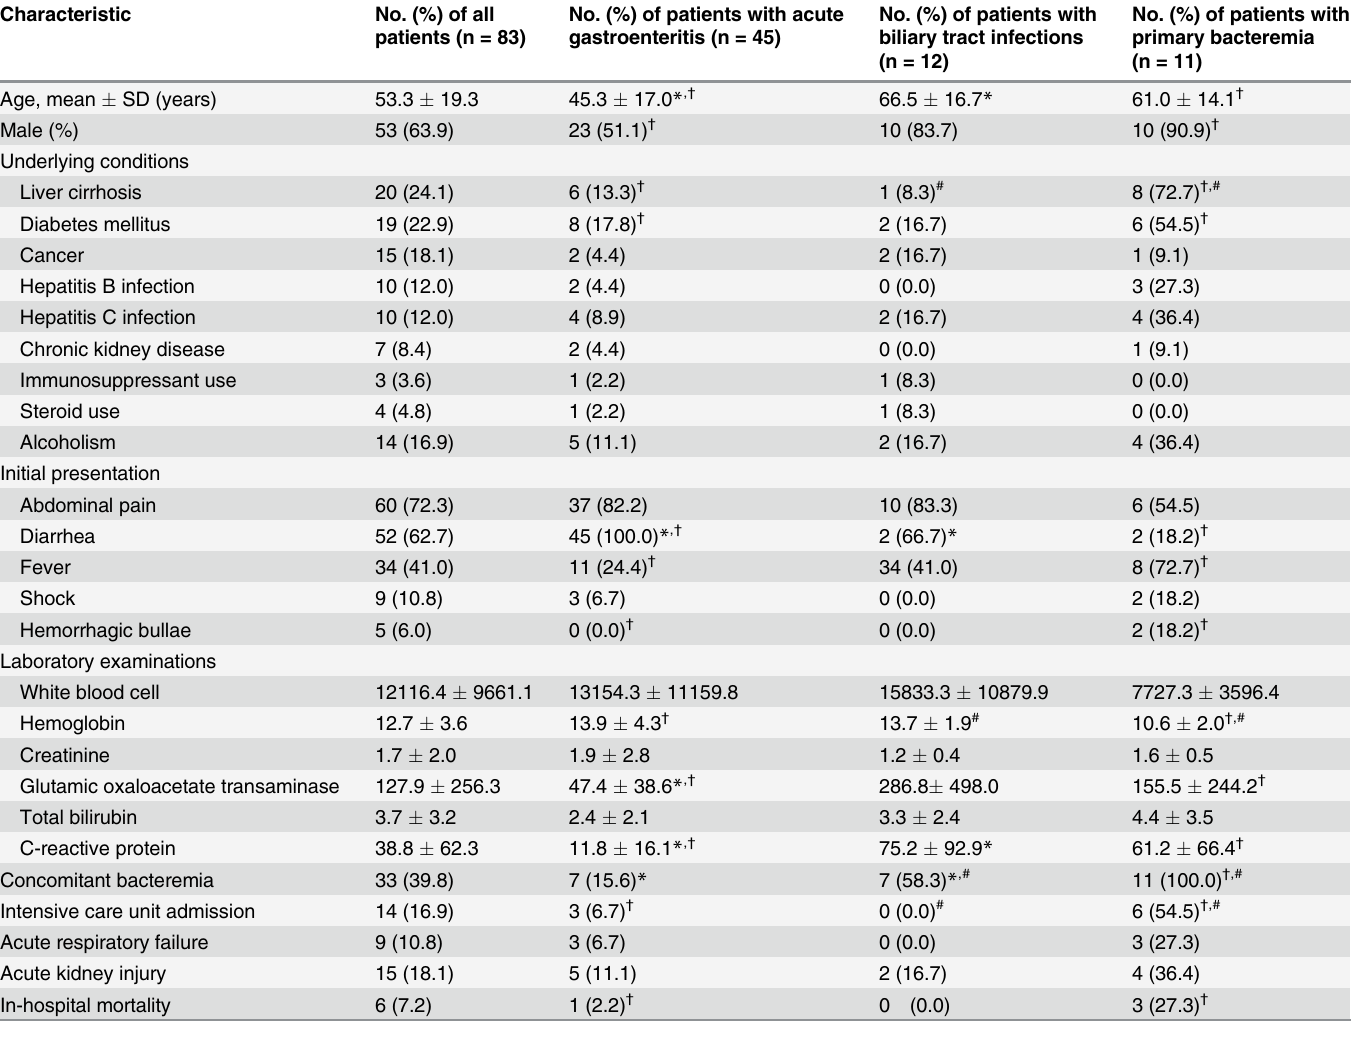
Table 1. Demographic characteristic of 83 patients with non-O1 Vibrio cholerae